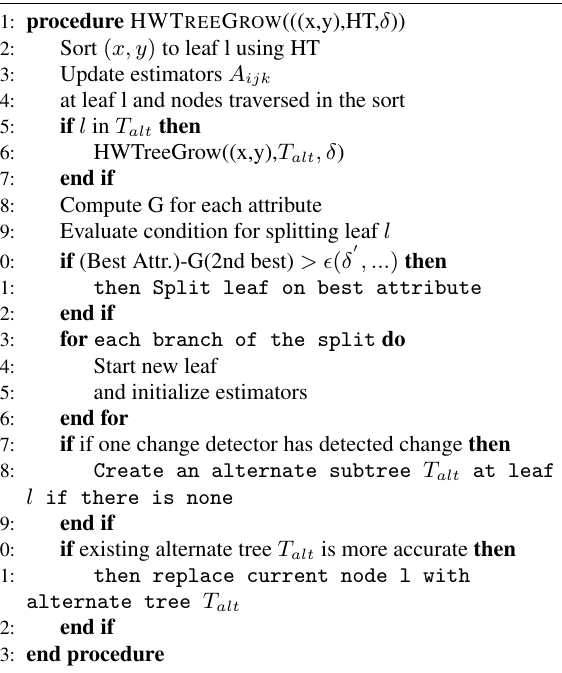
Algorithm 4 Hoeffding Window Tree(Stream δ